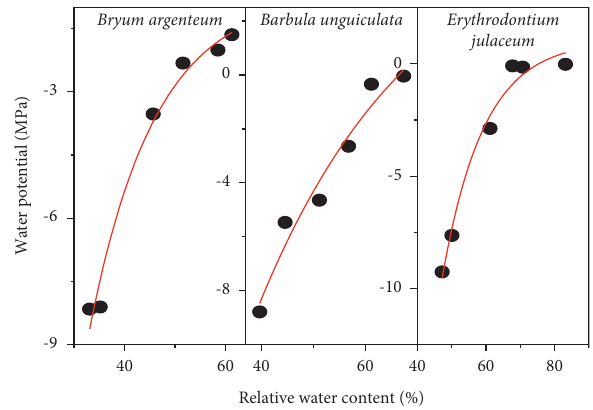
Figure 2: Relationship between water potential and RWC in three epilithic mosses during dehydration. Table 2: The effect of drought stress and the replenishment on photosynthetic physiology indexes in three epilithic mosses. Erythrodontium julaceum (Schwaegr.) Par. with permission from [24]. Copyright 2016 open-access from Bangladesh botanical society. Species Rewatering Stress Rewatering Stress Rewatering Bryum argenteum